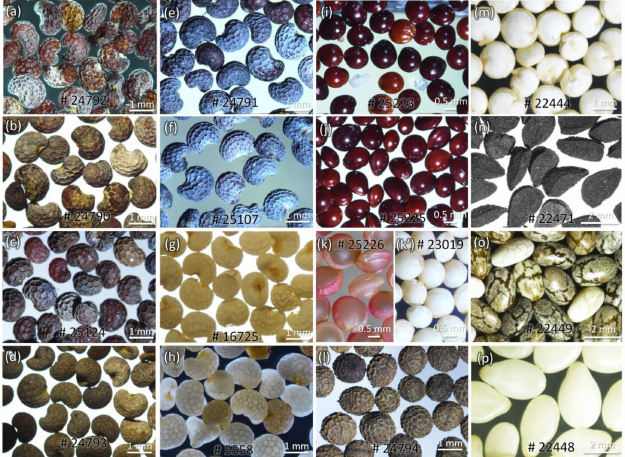
Figure 9. External morphology of poppy seeds and their adulterants. ( a – h ) P. somniferum (black, brown, white, and blue); ( i ) A. paniculatus; ( j ) A. cruentus ; ( k , k’ ) A. caudatus (pink and white, respec- tively); ( l ) E. californica ; ( m ) C. quinoa ; ( n ). N. sativa ; ( o ) S. hispanica ; and ( p ) S. indicum . Scale bar: 0.5 mm: ( i – k’ ); 1 mm: ( a – h , l , m ); 2 mm: ( n – p